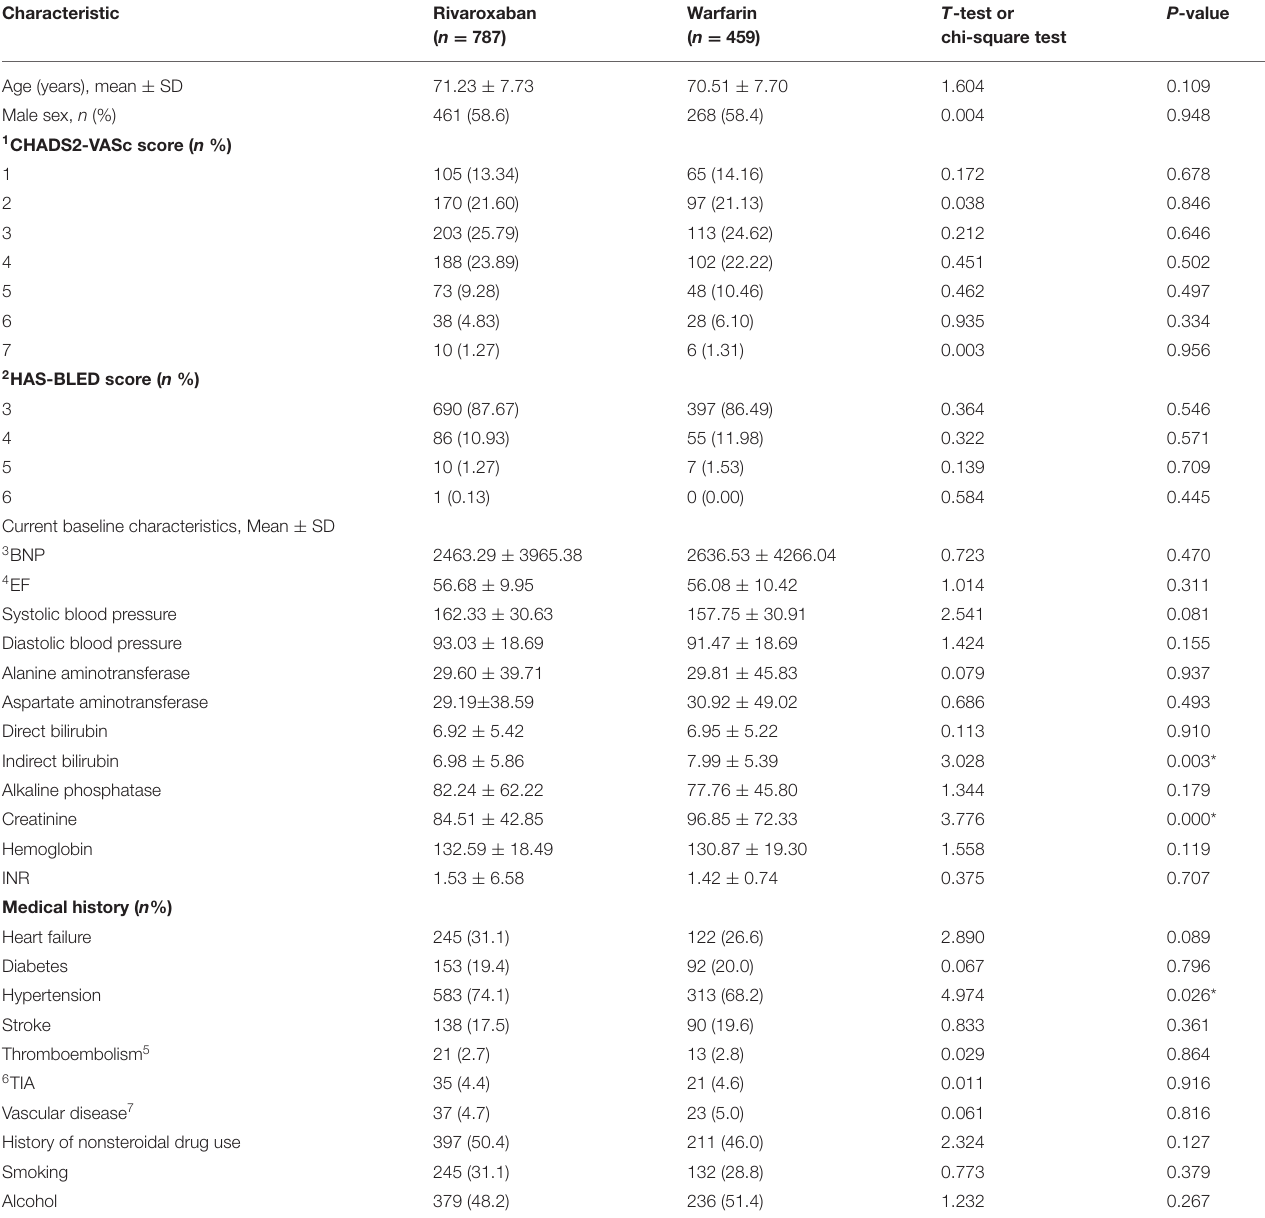
TABLE 1 | Baseline characteristics of the study population ( N =